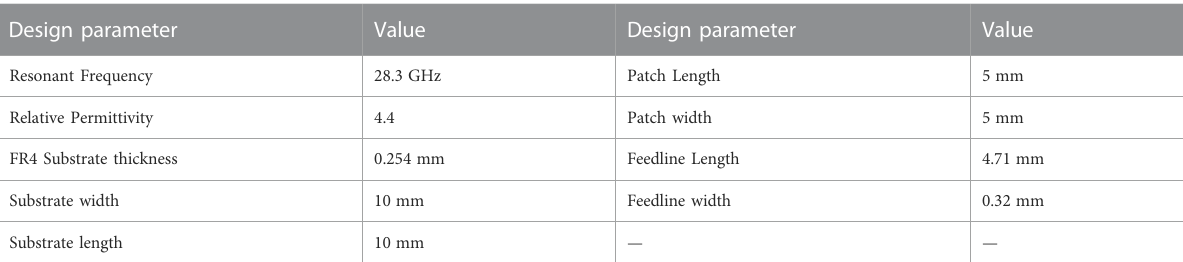
TABLE 2 Optimized dimensions of Patch antenna. Design